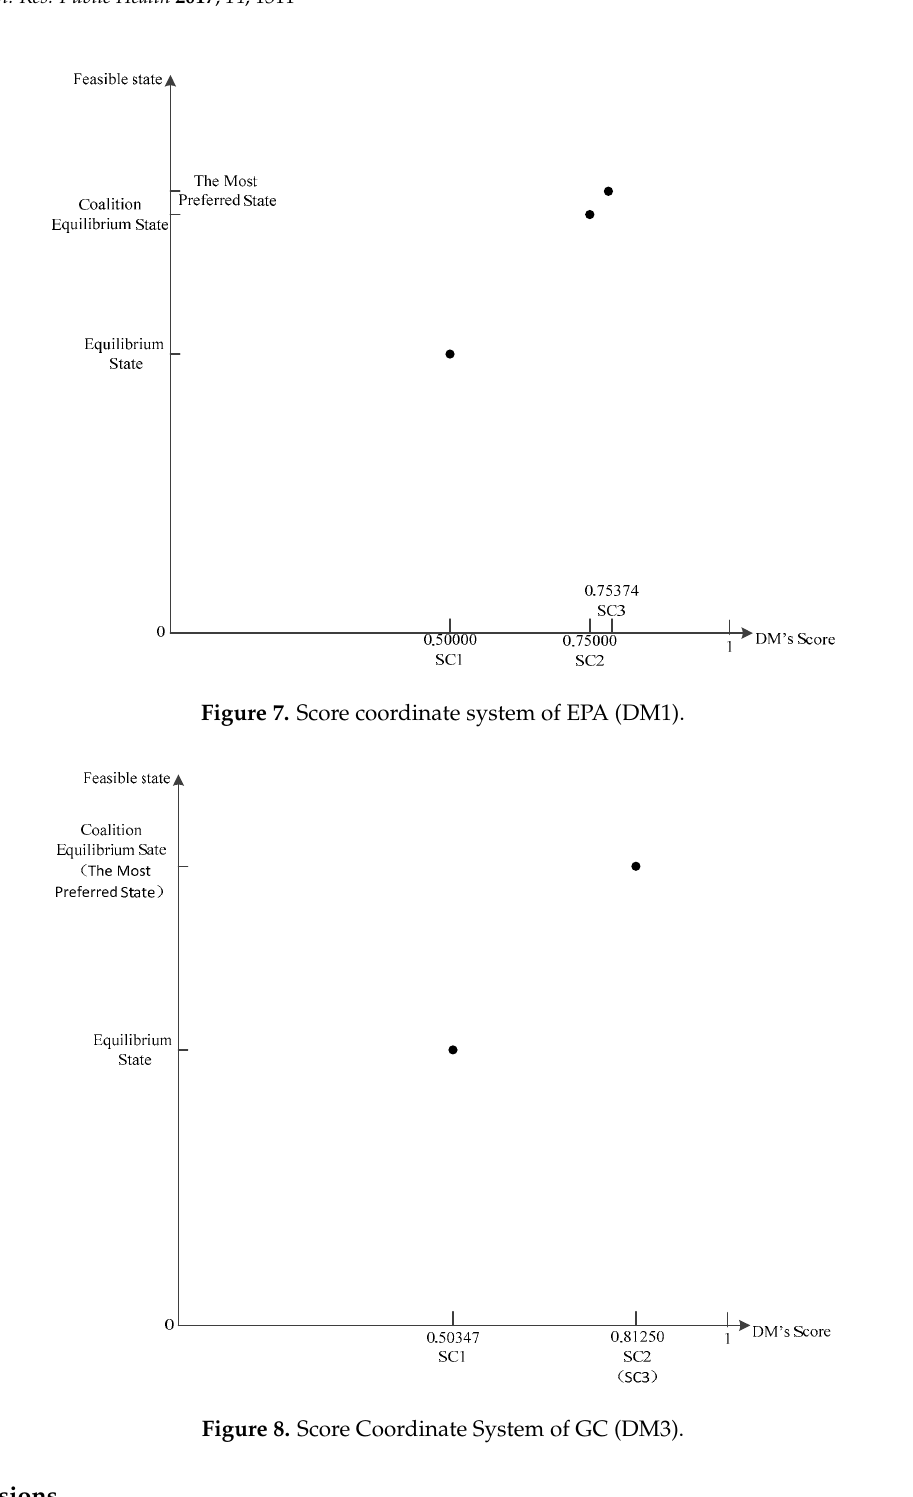
Figure 8. Score Coordinate System of GC (DM3).